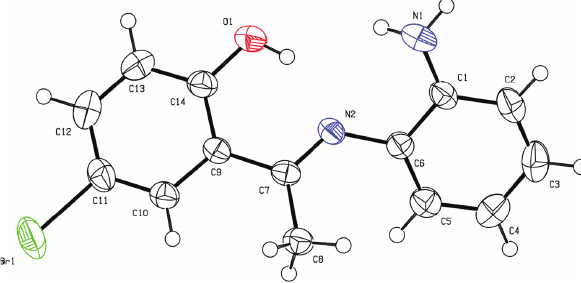
Table 1: Data collection and handling.